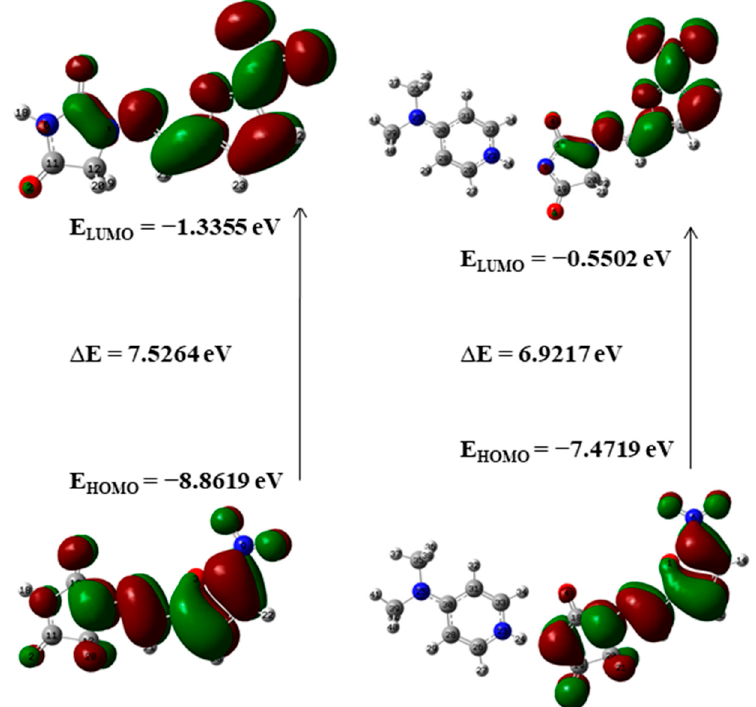
Figure 6. The HOMO-LUMO energy gap of NF and NF-DMAP calculated at the wB97X-D level of theory.